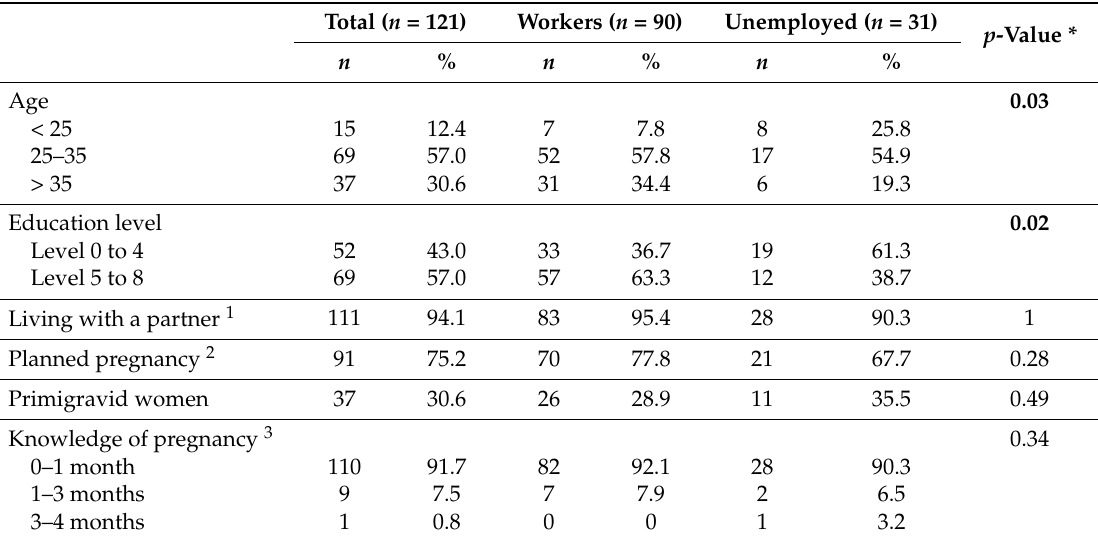
Table 1. Description of survey respondents ( n = 121).